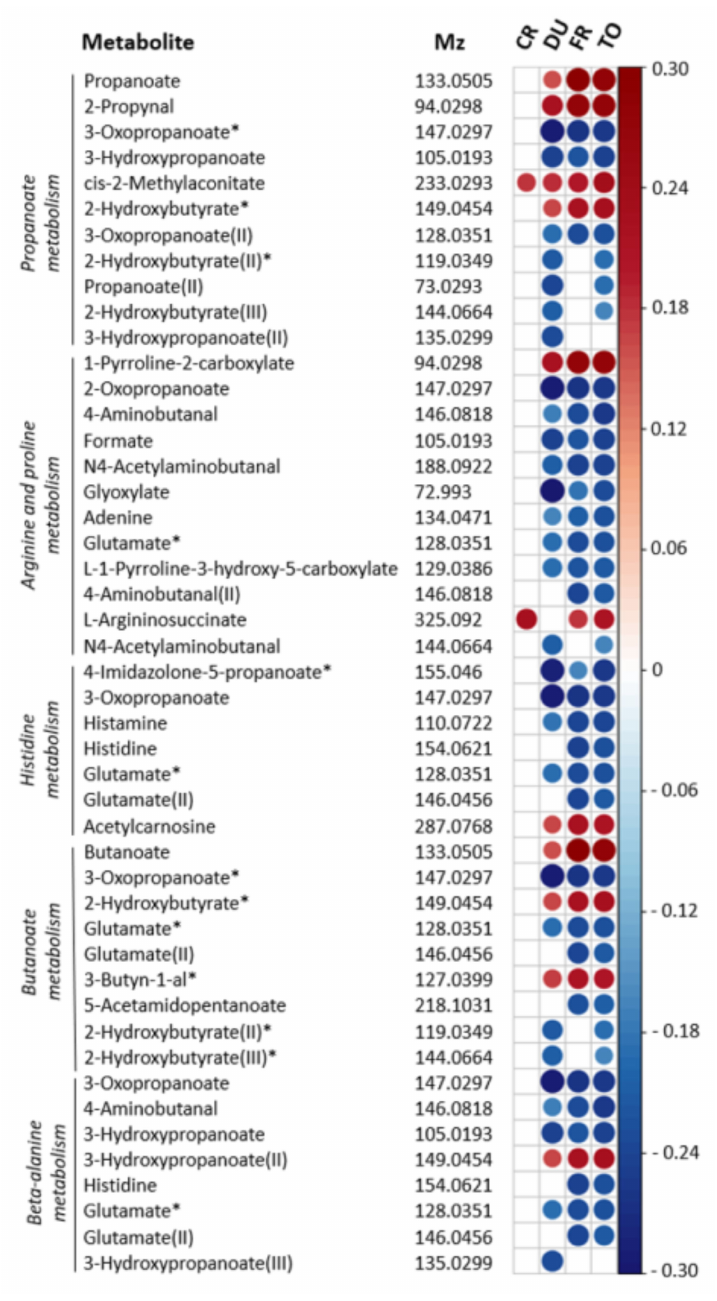
Figure 3. Spearman correlation plot for individual metabolites contributing to metabolic path- ways associated with substance use. Metabolic features associated with MATE-Q scores and in- volved in propanoate metabolism, arginine and proline metabolism, histidine metabolism, butanoate metabolism and beta-alanine metabolism are depicted. Strength and direction of the correlation coefficients are only shown for p < 0.01 (not FDR-corrected). Results are corrected for age, gen- der and BMI. The m / z values referring to multiple significant pathways are depicted multiple times. I, II, III = multiple m / z values could be identified as the same metabolites. * = m / z value identified as multiple possible metabolites within a pathway, see Supplementary Figure S4 for all options. CR = craving (OCDS), DU = duration of substance use, FU = frequency of substance use, TO = total MATE